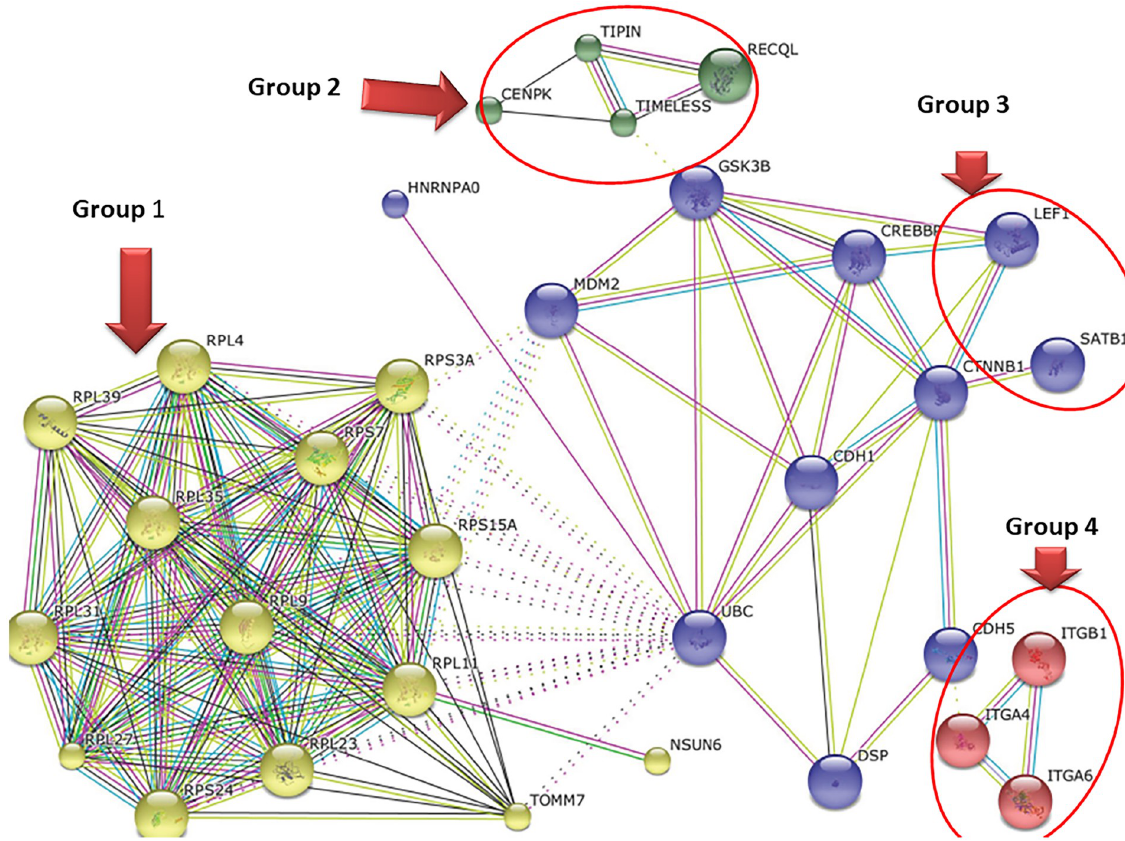
Fig 4. Interactive network of the regulatory molecules. String analysis was performed to study the protein-protein interaction. Downregulation of proteins differentially expressed in immunological failure HIV-1 subtype-C patients as compared to ART-R. Briefly, protein-protein interaction revealed four clusters with distinct biological functions. Group 1 : Molecules involved in viral transcription, viral genome expression, and translation termination or inhibition. Group 2 : Molecule involved in the cell cycle process. Group3 : CD4-positive, alpha-beta T-cell differentiation, and activation. Lymphoid enhancer-binding factor 1 (LEF-1) . Group 4 : Integrin-mediated signaling pathway.